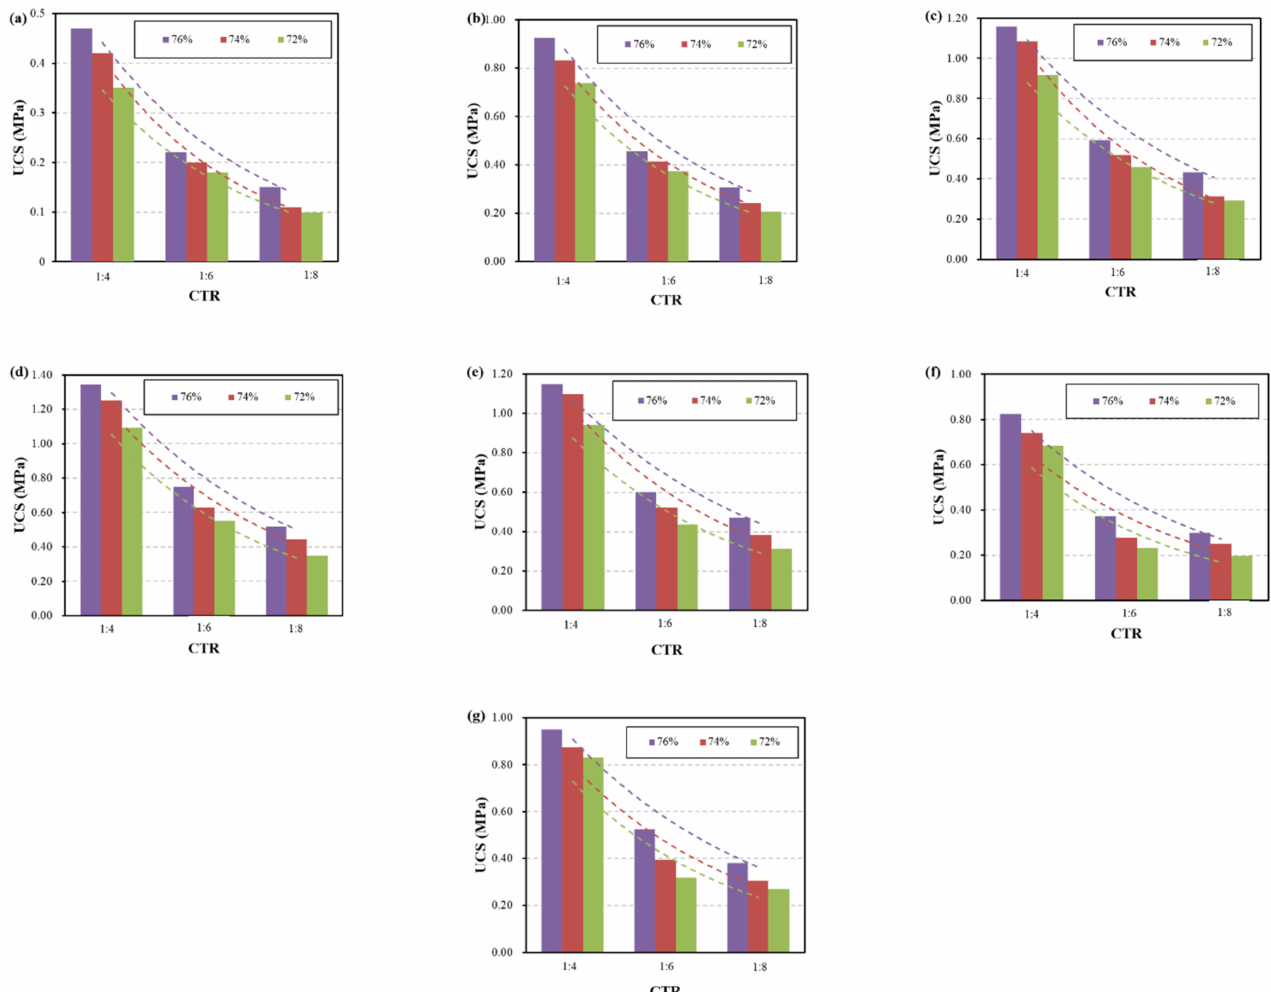
Figure 8. Relationships between the CTR and UCS of FCPB: ( a ) T = 3 d, FC = 1.5%; ( b ) T = 7 d, FC = 1.5%; ( c ) T = 14 d, FC = 1.5%; ( d ) T = 28 d, FC = 1.5%; ( e ) T = 28 d, FC = 2%; ( f ) T = 28 d, FC = 2.5%; ( g ) T = 28 d, FC =